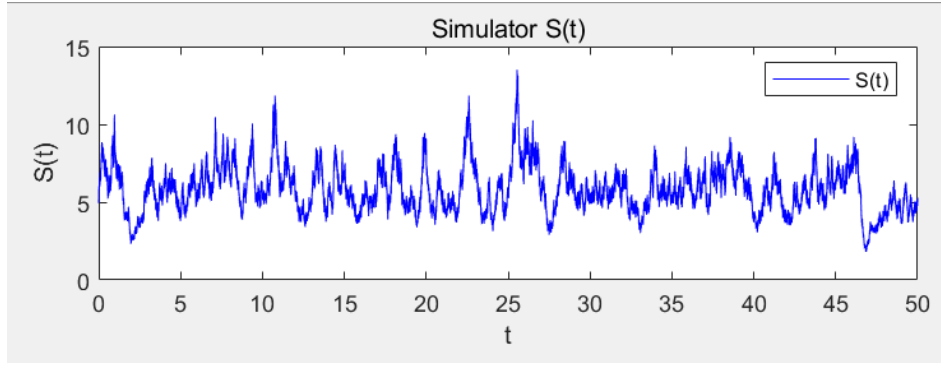
Figure 1. Sample path of S(t).